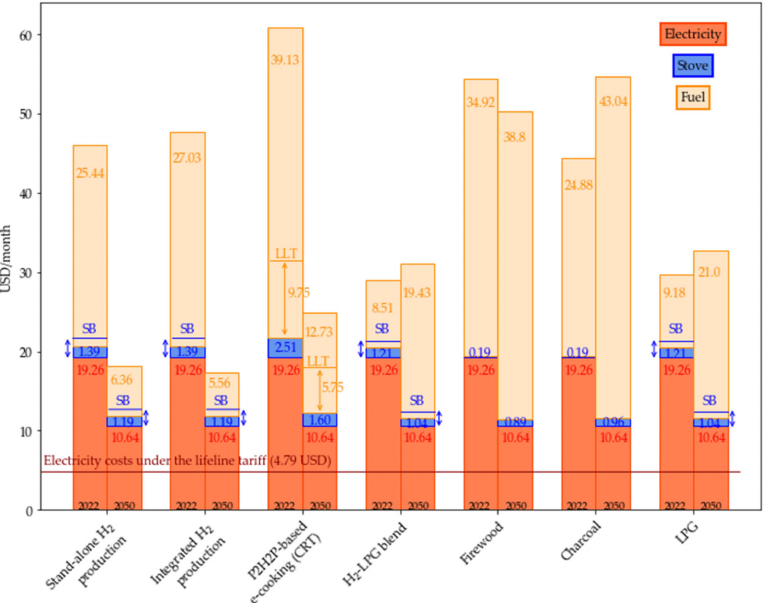
Figure 4. Monthly household energy costs in 2022 and 2050 (costs of cooking include fuel costs and stove financing). CRT = cost-reflective tariff (average privately owned mini-grid tariff); LLT = lifeline tariff; SB = single burner